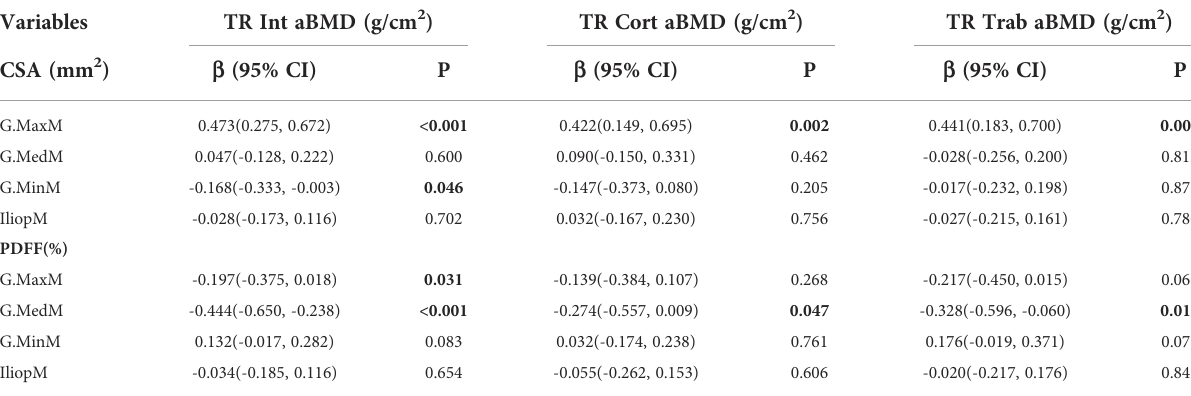
TABLE 4 Generalized multiple linear standardized regression coef fi cients and 95% CIs between the aBMD of the TR and various muscle indexes a, b,c in males.